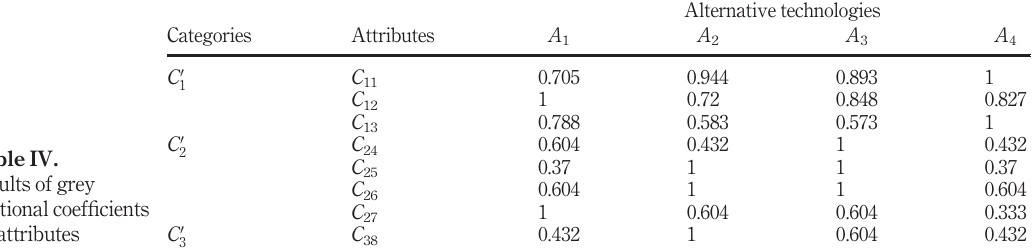
Table III. Results of grey relational generation for wastewater treatment technology selection